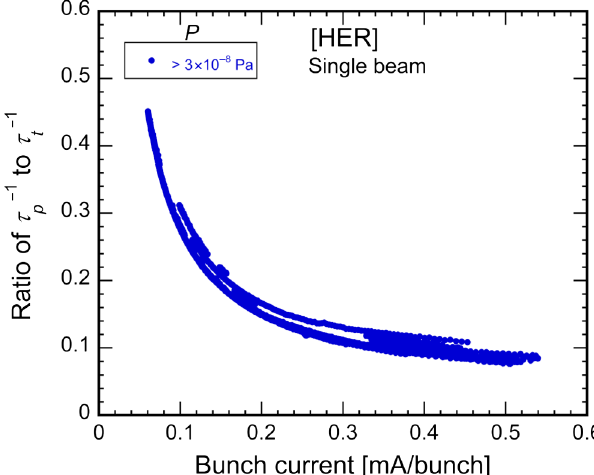
FIG. 18. Ratio of the first term ( 1 = τ p ) to the second term ( 1 = τ t ) of the right-hand side of Eq. (18) for the HER.